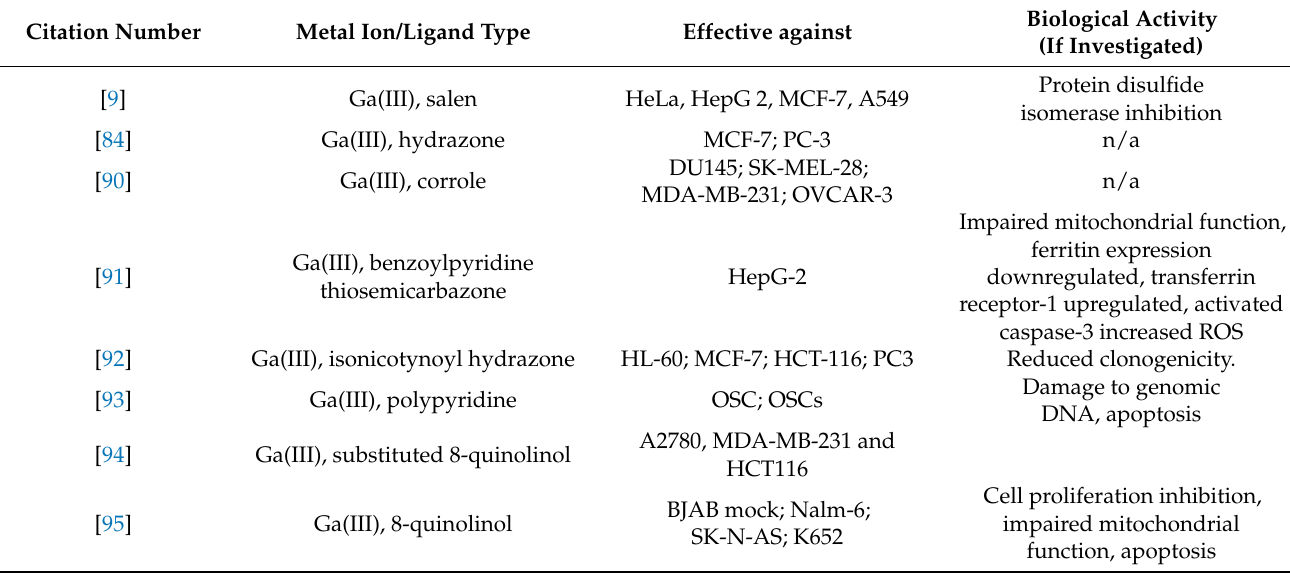
Table 3. Summary of the gallium complexes